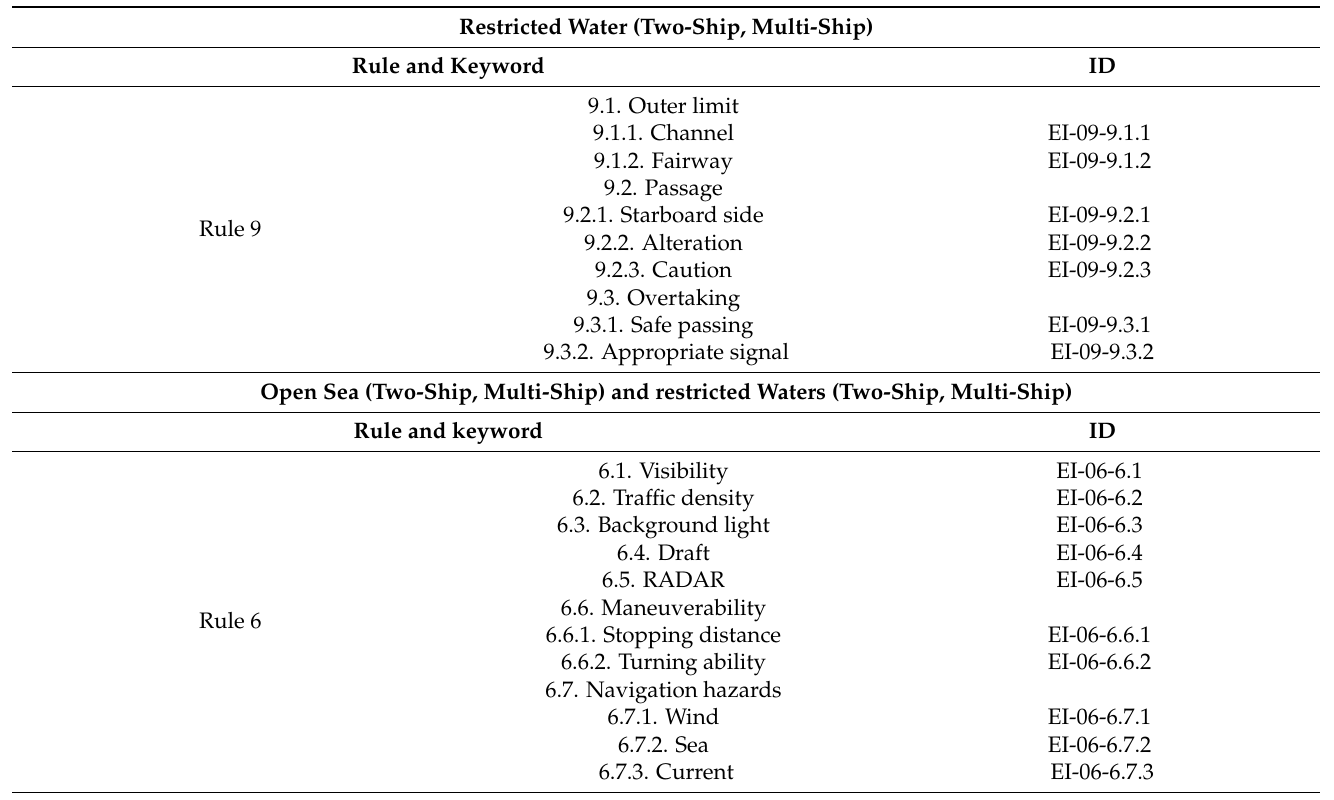
Table A2. Requirements specifications for environmental